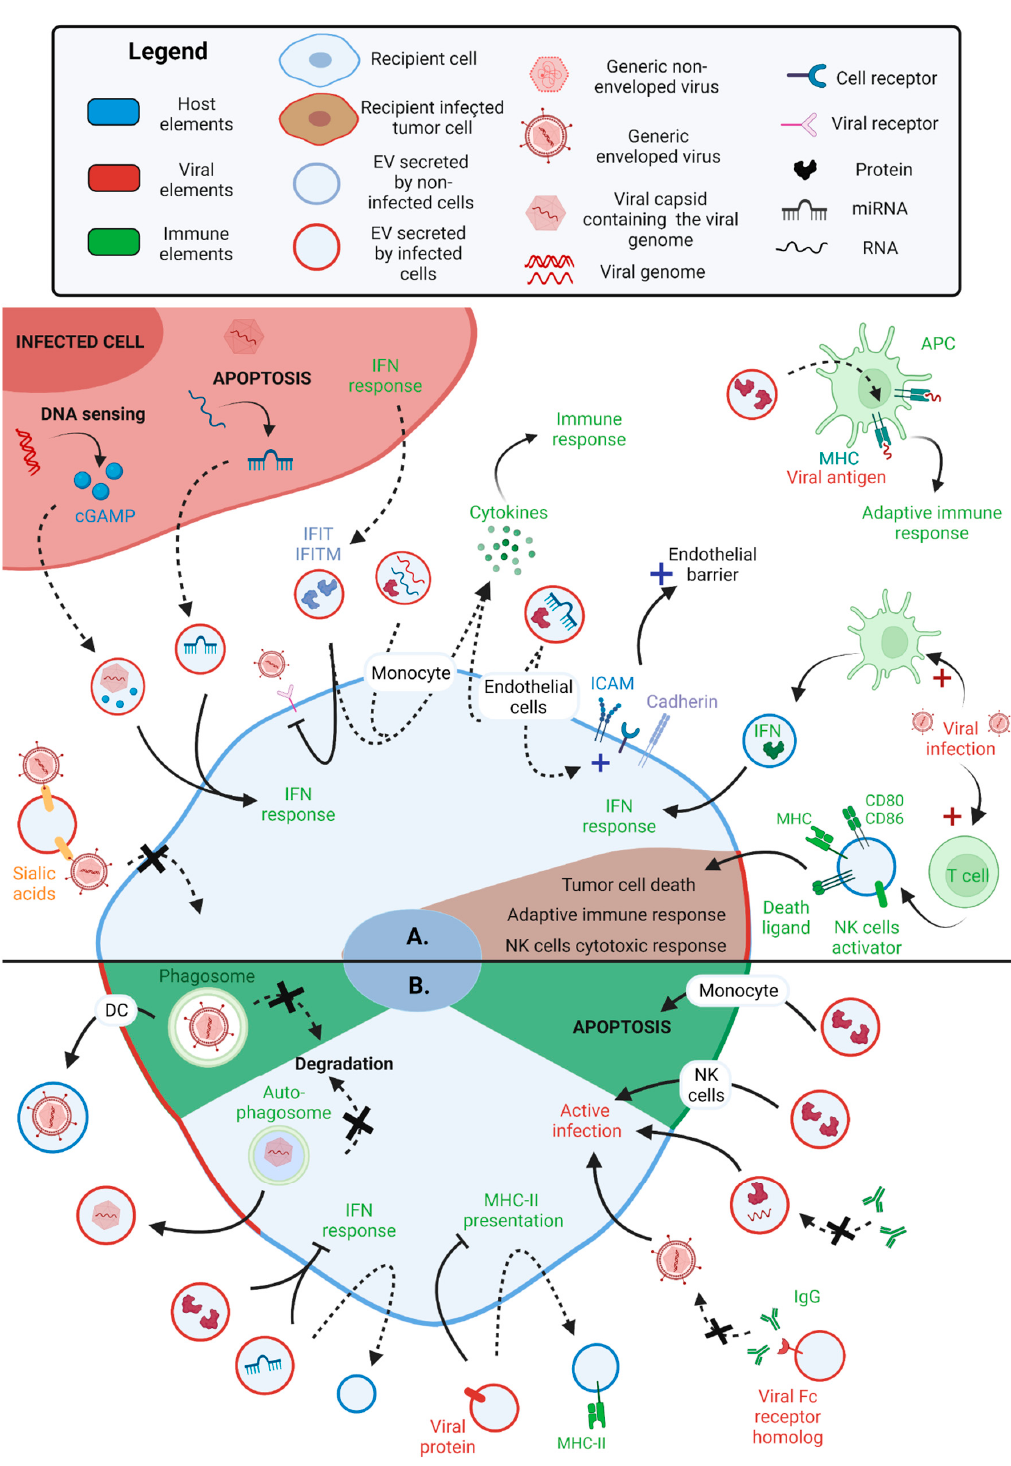
Figure 3. EVs and viruses modulate the immune response. ( A ) EVs secreted by both infected and non-infected cells promote the antiviral immune response. Virus-EVs enriched in transmembrane sialic acids bind viral particles and prevent them from infecting new cells [IAV [88]. Viral infection induces the production of molecules such as cGAMP due to viral DNA sensing [HIV [83] or miRNA due to virus-induced apoptosis [IAV [82]. These molecules can be transported via EVs to activate down- stream antiviral IFN response in recipient cells. Virus-EVs also transfer IFN-induced molecules (IFIT